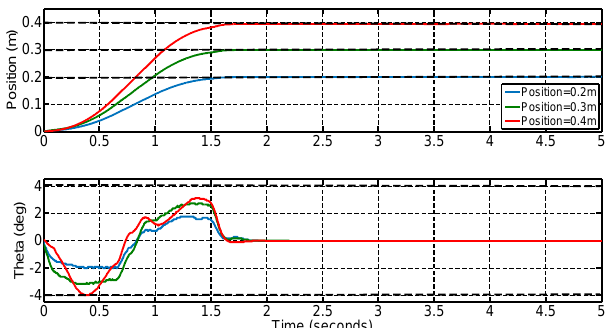
Figure 12. The time-optimization response within a time-optimal scheme. Table 6. Performance within a time optimal solution.